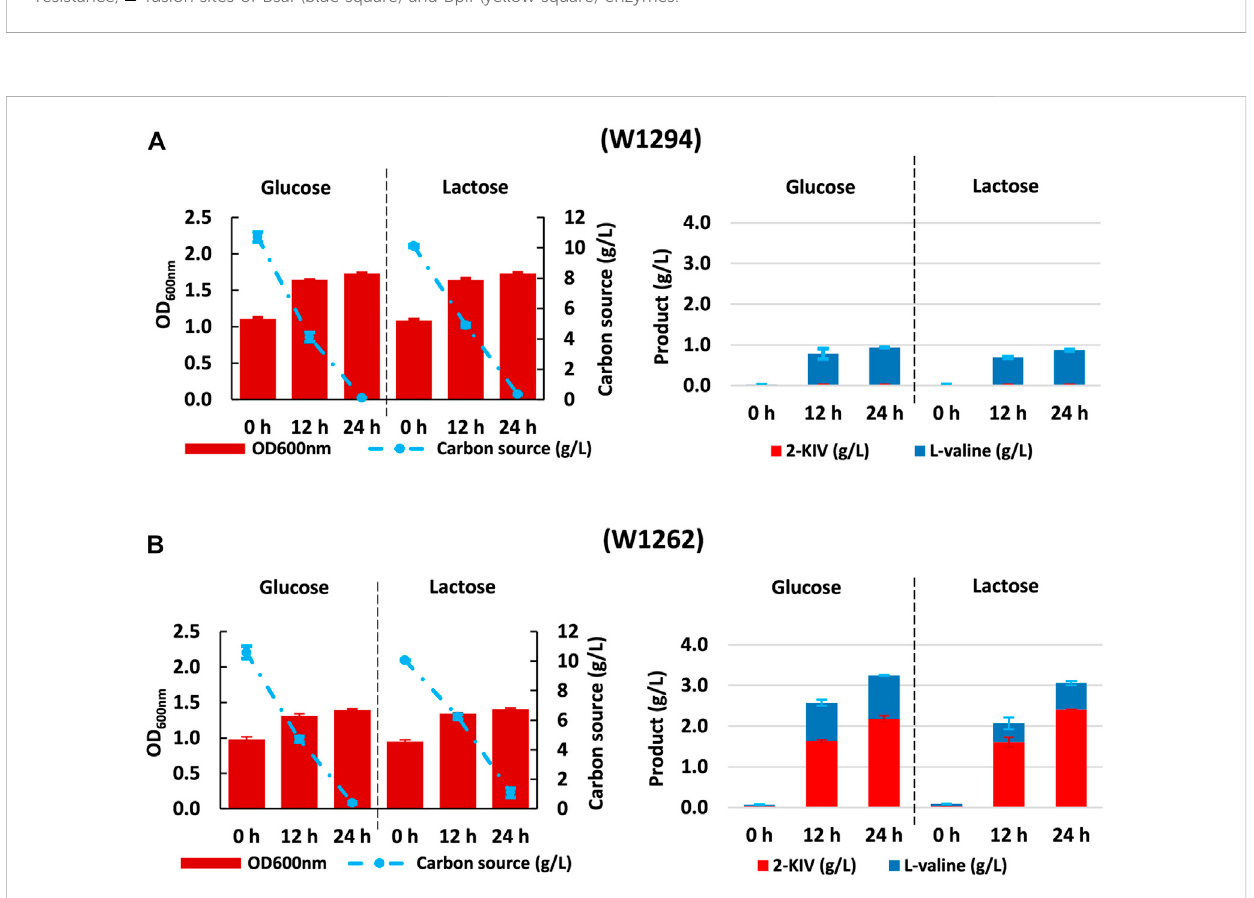
FIGURE 8 Kinetic of Growth, substrate uptake and 2-ketoisovalerate and L-valine production of E. coli W1294 (A) and E. coli W1292 (B) in shake fl ask experiments using glucose and lactose. Error bars indicate the difference between replicate cultures.